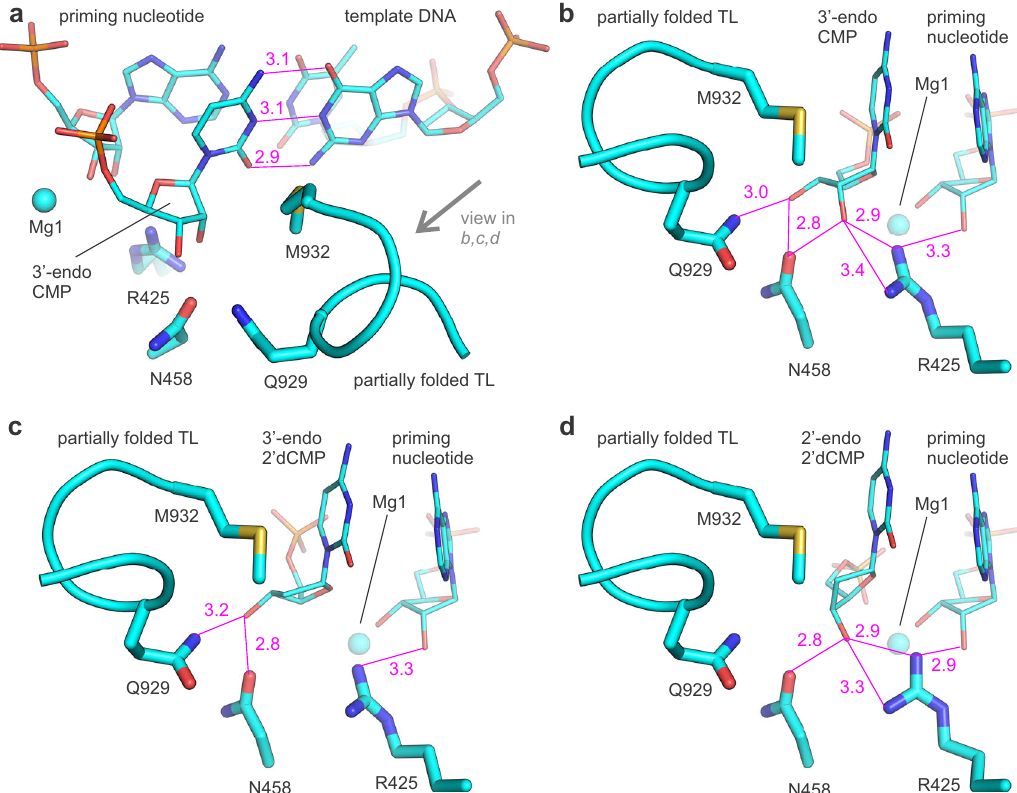
Fig. 5 Docking models of T. thermophilus RNAP with ribo- and deoxyribonucleotides. In silico docking of the 3 ′ -endo CMP ( a , b ), 3 ′ -endo 2 ′ dCMP ( c ), and 2 ′ -endo 2 ′ dCMP ( d ) in the semi-closed active site of T. thermophilus RNAP. Magenta numbers are interatomic distances in Å. Source data are provided as a Source Data fi